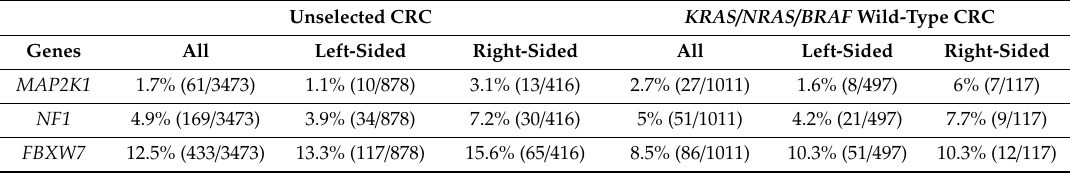
Table 1. Frequency of MAP2K1 , FBXW7 , and NF1 mutations in CRC and correlation with sidedness based on cBioPortal